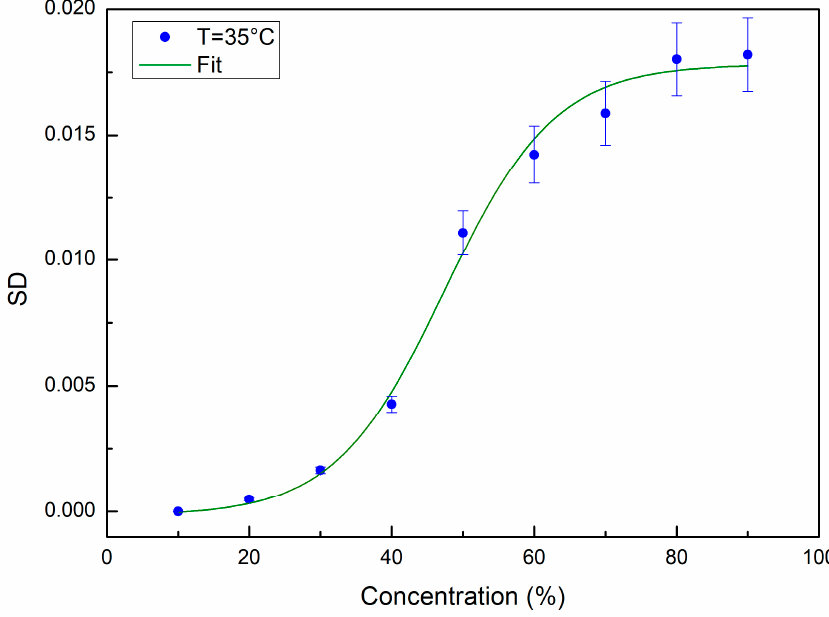
Figure 7. SD values calculated for T = 35 °C (blue circles) together with the fitting curve, i.e., green curve.